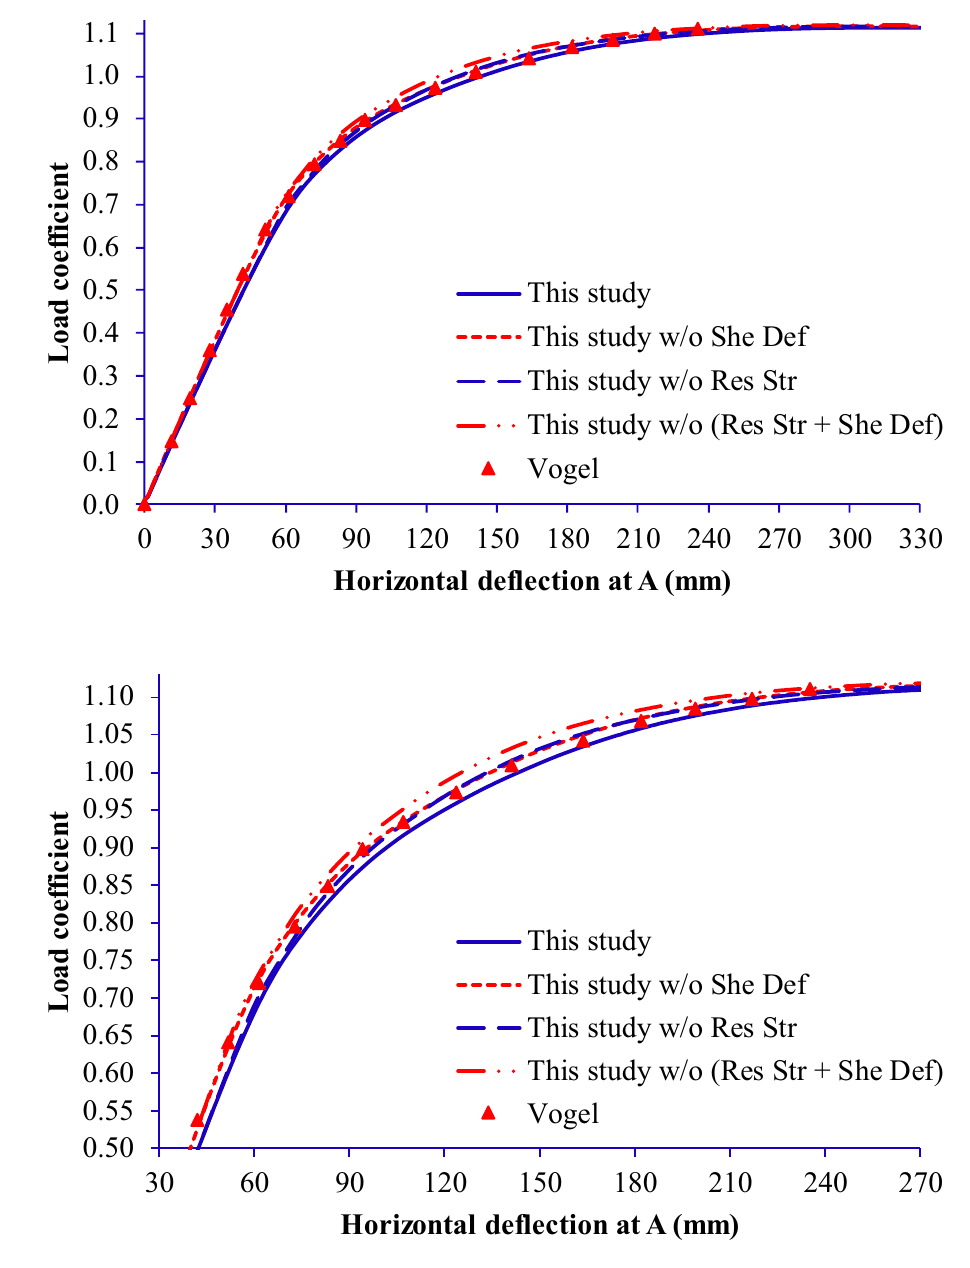
Fig. 12 Load-horizontal deflection relationship at A of six-story framewith different effects